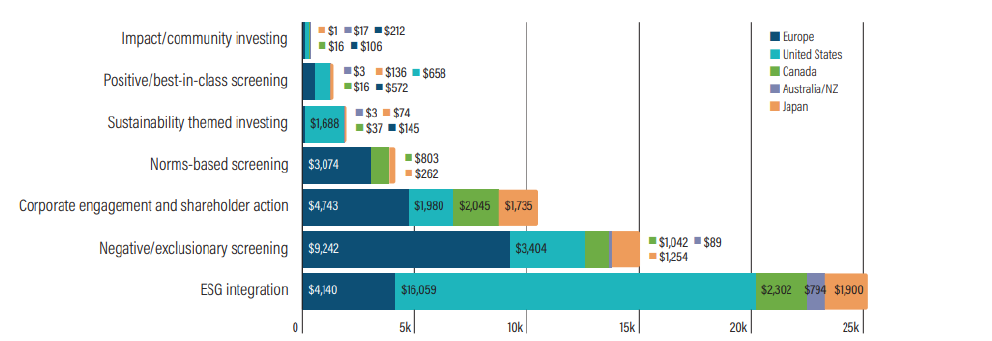
Figure A11. SRI assets by strategy and region